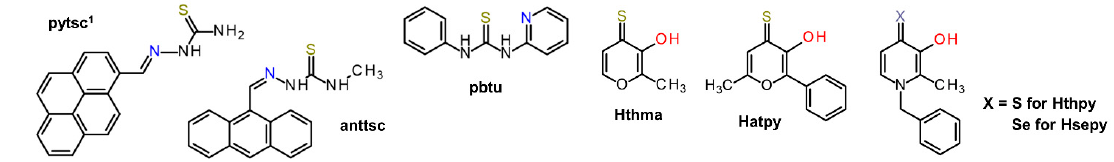
Figure 5. Structural formulas of selected bidentate N , S- , O , S- and O,Se -donor L^L ligands, with donor atoms given in blue (N), dark yellow (S) or red (O), and X stands for S or Se.